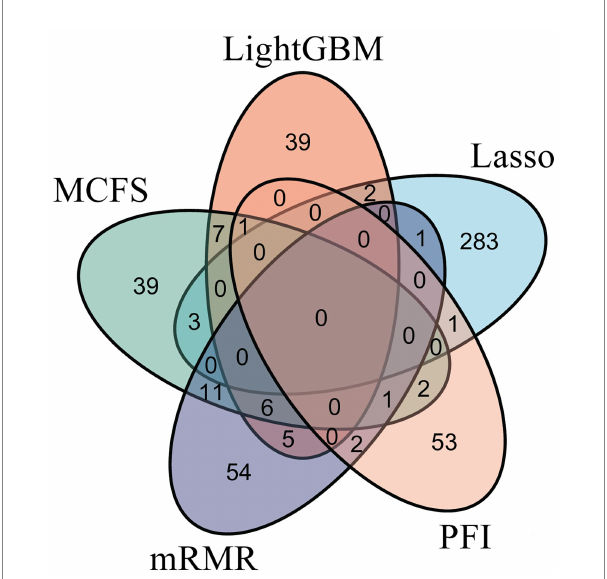
FIGURE 7 Venn diagram of the feature sets used to construct feasible random forest classifiers on five feature lists that were obtained by Lasso, LightGBM, MCFS, mRMR, and PFI, respectively. The overlapping circles indicated genes that occurred in multiple sets. These genes were deemed to be important by multiple feature ranking